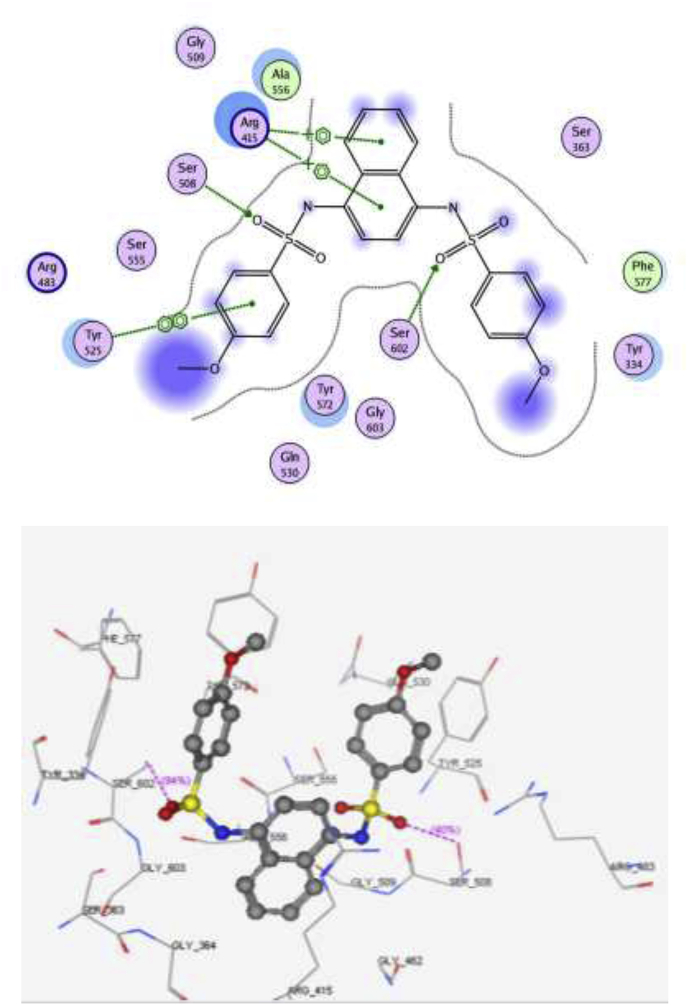
2D and 3D interaction poses of the N,N′-naphthalene-1,4-diylbis(4-methoxybenzenesulfonamide showing cation-π, π-π interaction and hydrogen bonds with the key amino acids inside the binding pocket.